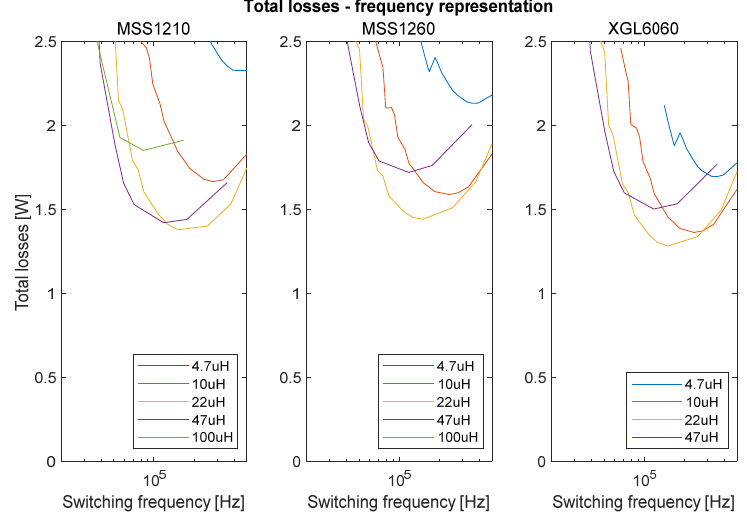
Figure 22. Total mosses modelling results for the three inductor families. Total losses are represented as a function of the switching frequency and the inductor values.